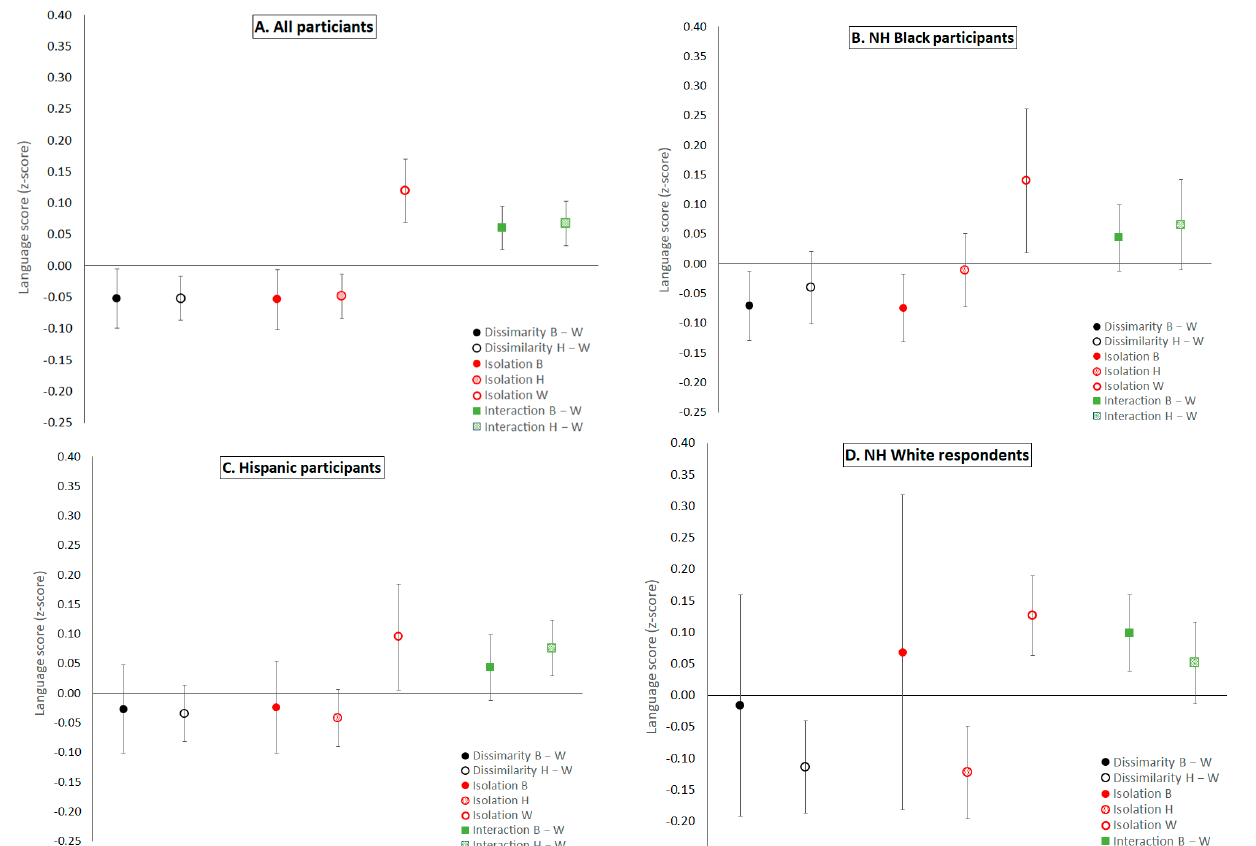
Figure 3. Association of residential segregation indices and language scores for the whole sample ( A ) and three race/ethnicity groups ( B – D ), which were derived from models with a segregation index x ace/ethnicity interaction (estimates in Tables 2 and 3). The models controlled for age, sex/gender, race/ethnicity, childhood socioeconomic position, years of education, occupation, language of test administration, birthplace, and recruitment cohort. For all indices, we used the mean value within our sample to create binary indicators of segregated census blocks. Higher dissimilarity and isolation indicate a block group with more people from minoritized backgrounds, whereas higher interaction indicates more desegregated areas. Note: confidence intervals for effect of living in census blocks where the majority of residents are NH Black adults (isolation B and dissimilarity B-W) on NH White respondents (panel D ) have large confidence intervals due to small sample sizes ( n = 14 and n = 43, respectively). Table 3. Results of multilevel linear or Cox models with an interaction between segregation index and race/ethnicity estimating the association of residential segregation with later life cognitive abilities among respondents from different groups. Estimates for which the 95% confidence intervals do not include the null are highlighted in bold.